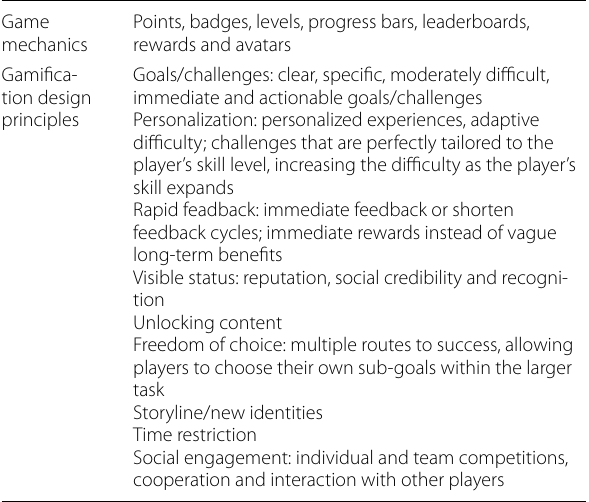
Table 4 Game mechanics and gamification design principles Game Points, badges, levels, progress bars, leaderboards, mechanics rewards and avatars Gamifica- tion design principles